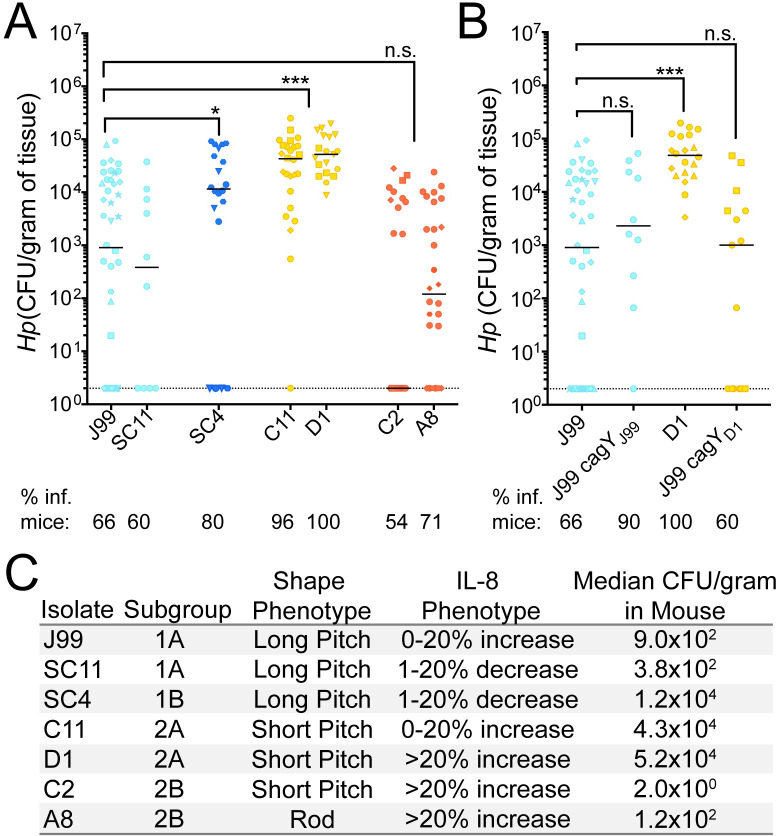
Mouse colonization among isolates from distinct subgroups differs and is not explained by cagY variation.(A-B) Each point represents the colony forming units per gram of mouse tissue homogenate from a single mouse. Two CFU/gram is the limit of detection (dotted line). Biological replicates indicated by different symbol shapes with the median are shown. P-values were calculated from pooled experimental replicates using a Mann-Whitney non-parametric test (n.s. not significant, * p<0.05, *** p<0.001). Percentage of mice with bacterial colonization above the limit of detection (% inf. mice) is indicated below the isolate names. (A) Colonization in WT B6 mice 1 week post infection with representative isolates from each subgroup. Color indicates maximum likelihood tree subgroup 1A (light blue), 1B (dark blue), 2A (yellow), and 2B (red). (B) Alleles of cagY from indicated strains were engineered into strain J99 at the native locus and resultant isolates used for infection experiments. Data points in blue are mice infected with J99 variant of cagY and points colored in yellow were infected with D1 variant of cagY. (C) Summary of representative isolate phenotypic characteristics including the subgroup, bacterial shape, IL-8 phenotype (relative IL-8), and median mouse colonization (CFU/gram).